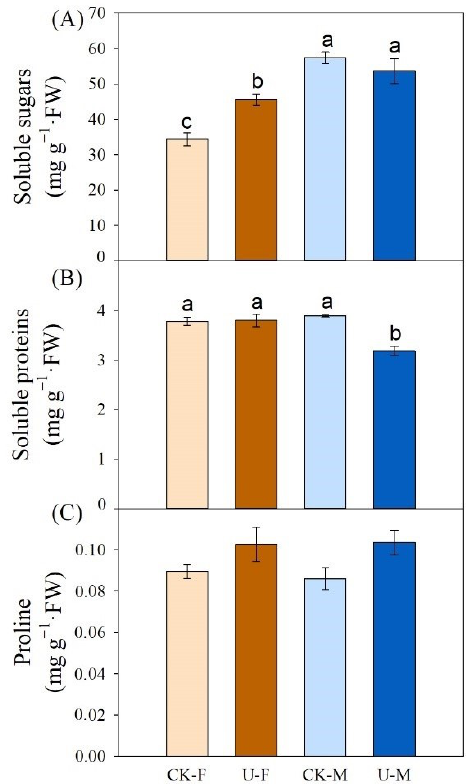
Figure 6. U on female and male trees of P. cathayana in leaves: effects on soluble sugars ( A ), soluble proteins ( B ), and proline ( C ). Values are expressed as means ± SE ( n = 3). Different letters represent significant differences between treatments ( p < 0.05).